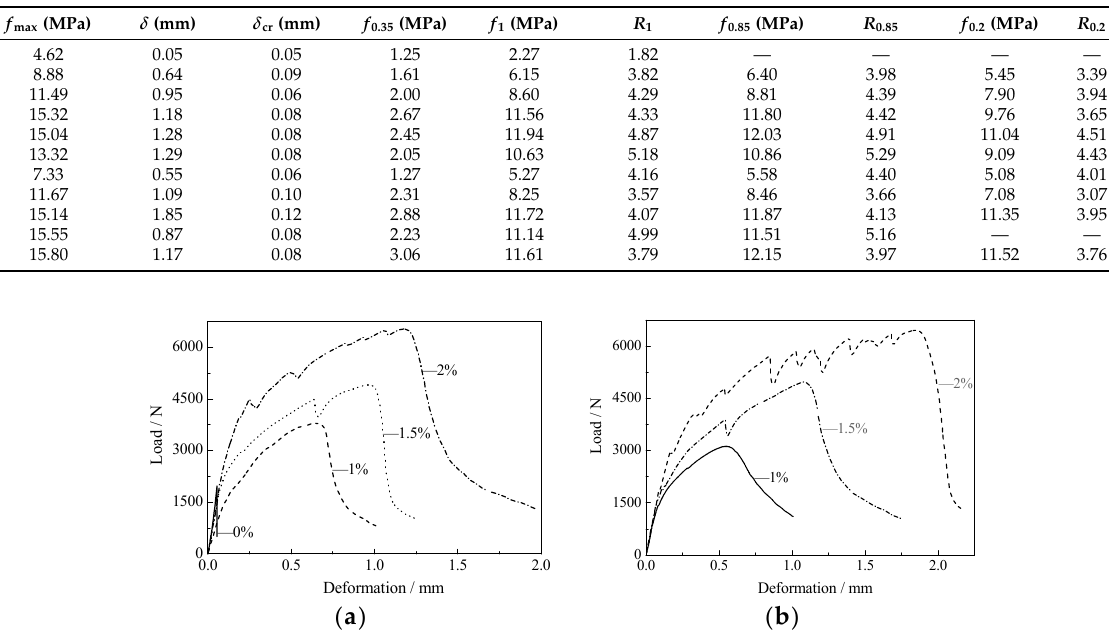
Table 3. Test results and flexural toughness indexes of specimens.